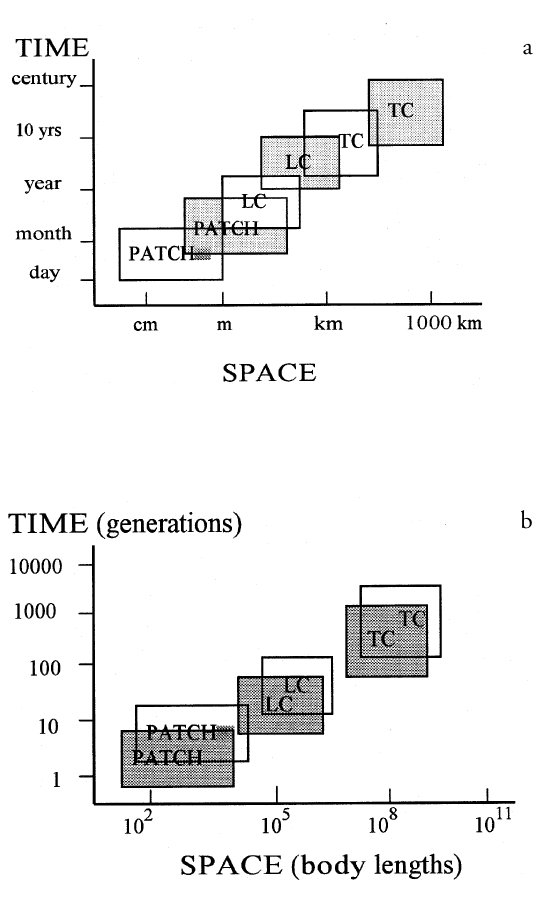
Fig. 3. Spatio-temporal ranges occupied by various entities of micro- (open) and macrofauna (shaded). PATCH: micropatches, LC: local community, TC: community